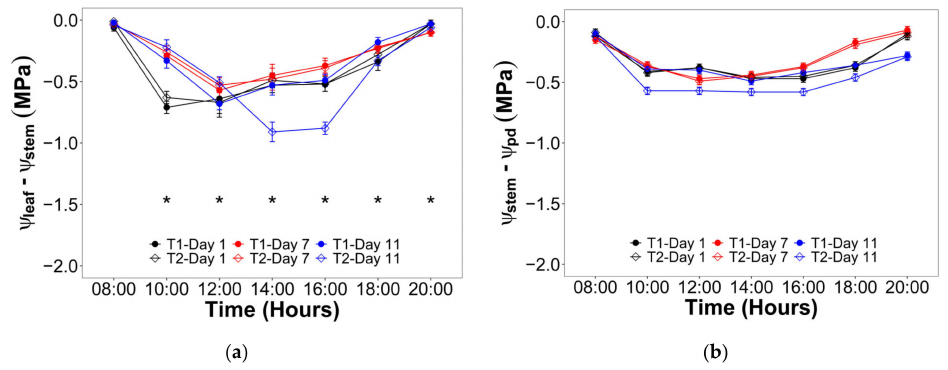
Figure 4. Hourly evolution of the water potential differential during the three evaluated days in the vegetative stage between: ( a ) Leaf and stem ( ψ leaf − ψ stem ); ( b ) Stem and root represented by the predawn water potential ( ψ stem − ψ pd ). Significant differences between irrigation treatments in the three evaluated days for every hour are indicated by an